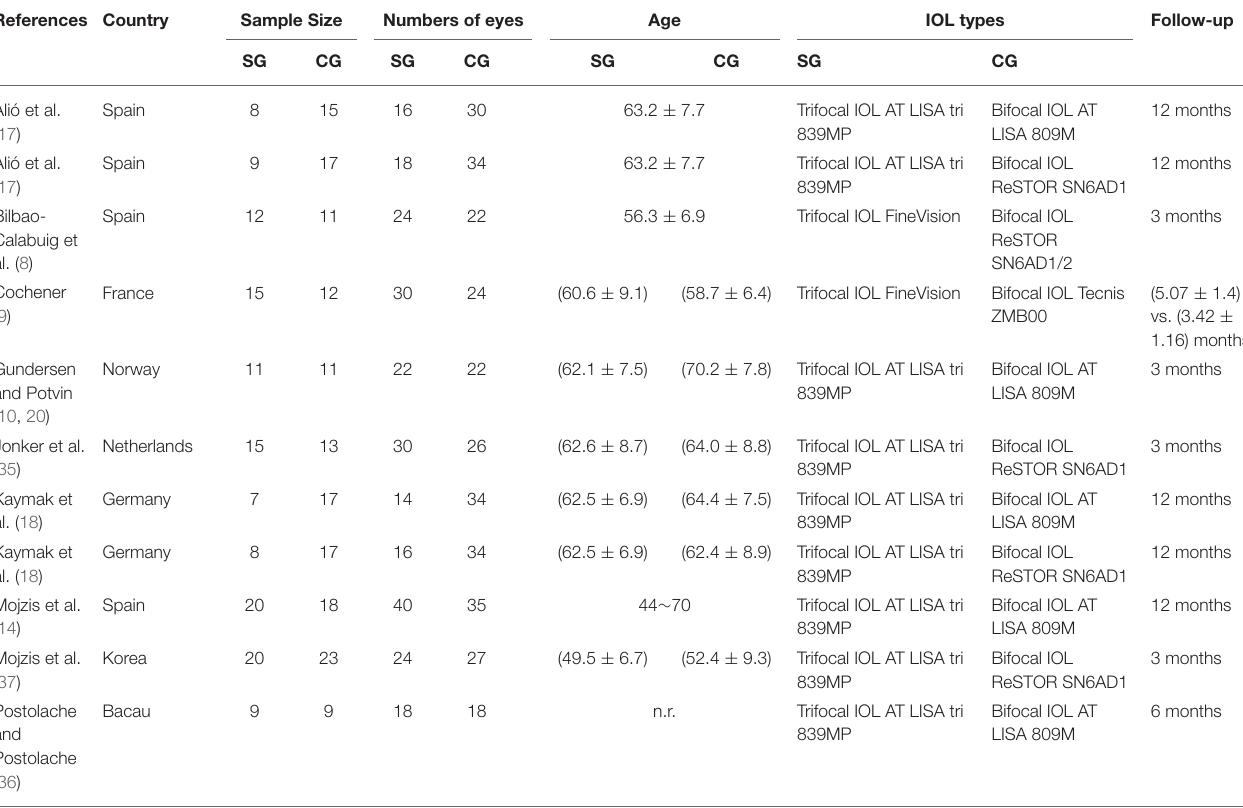
TABLE 1 | Basic characteristics of all eligible studies (11